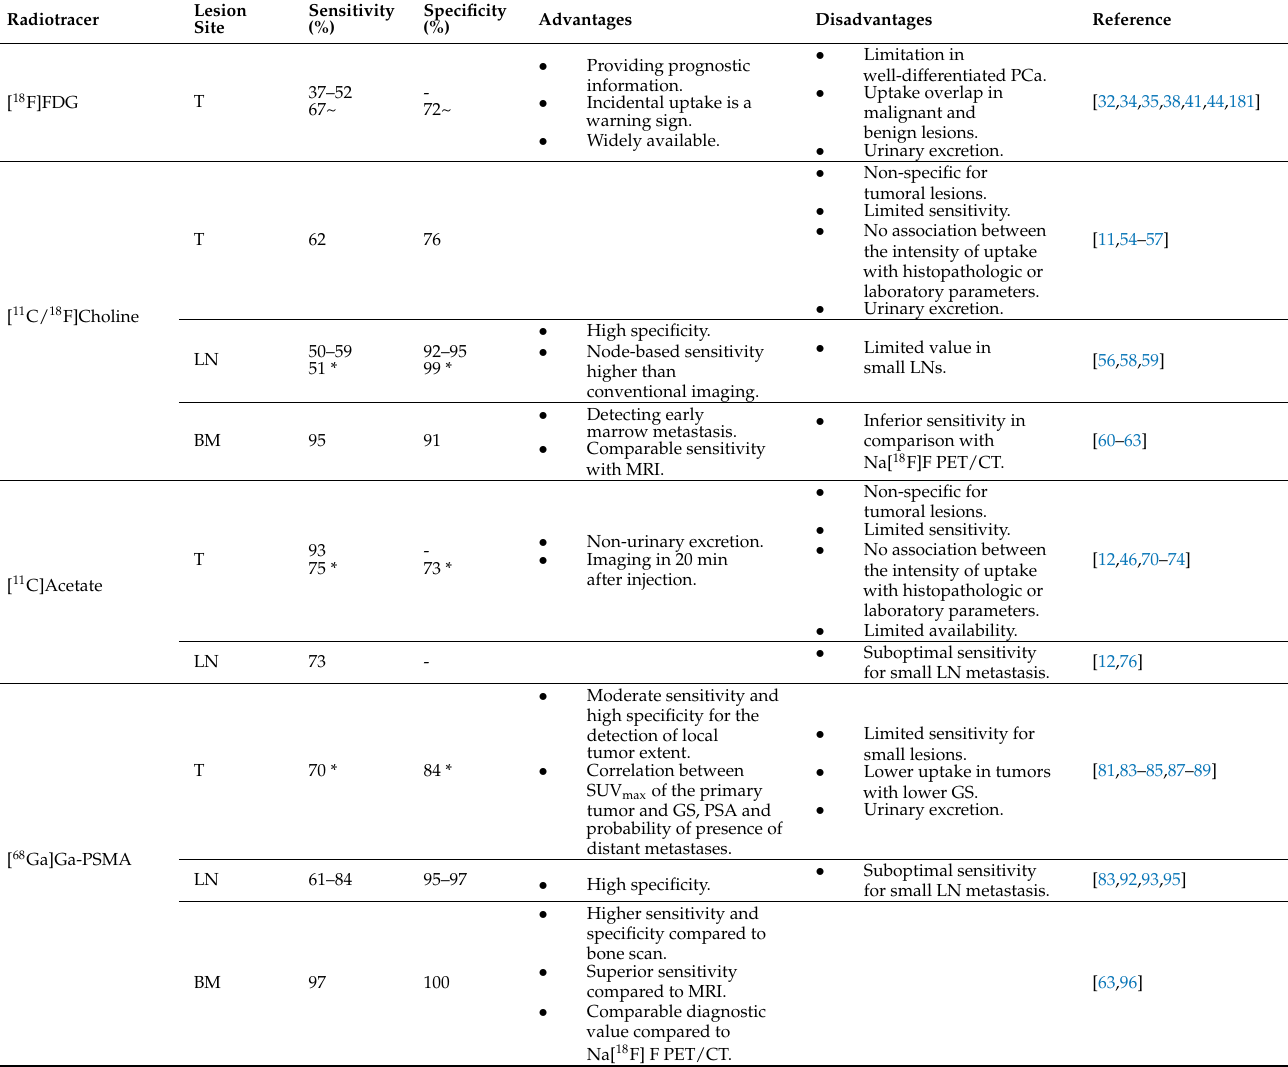
Table 1. Diagnostic performance, advantages, and disadvantages of different radiotracers in the evaluation of the primary staging of prostate